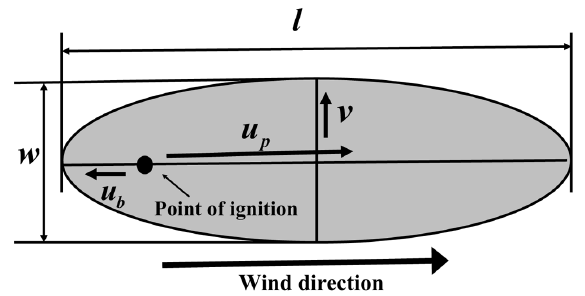
Fig. 5. Conceptual elliptical fire shape that is used to estimate the burned area with the wind direction along the major axis and the point of ignition at one of the